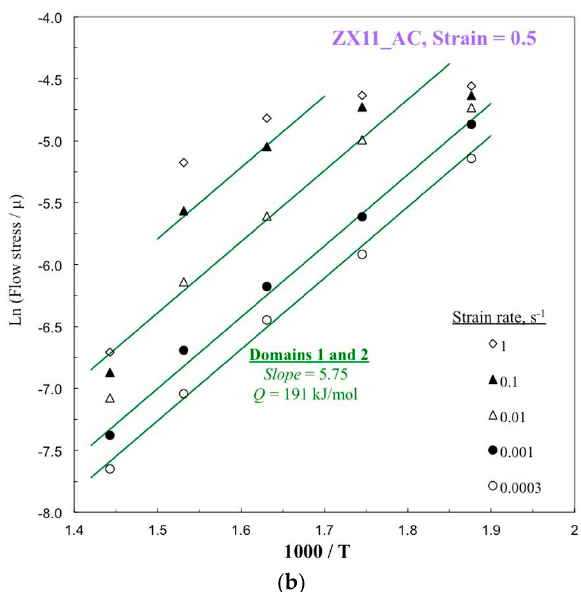
Figure 8. ( a ) Flow stress vs. strain rate, and ( b ) normalized flow stress vs. reciprocal of absolute temperature for ZX11 alloy.